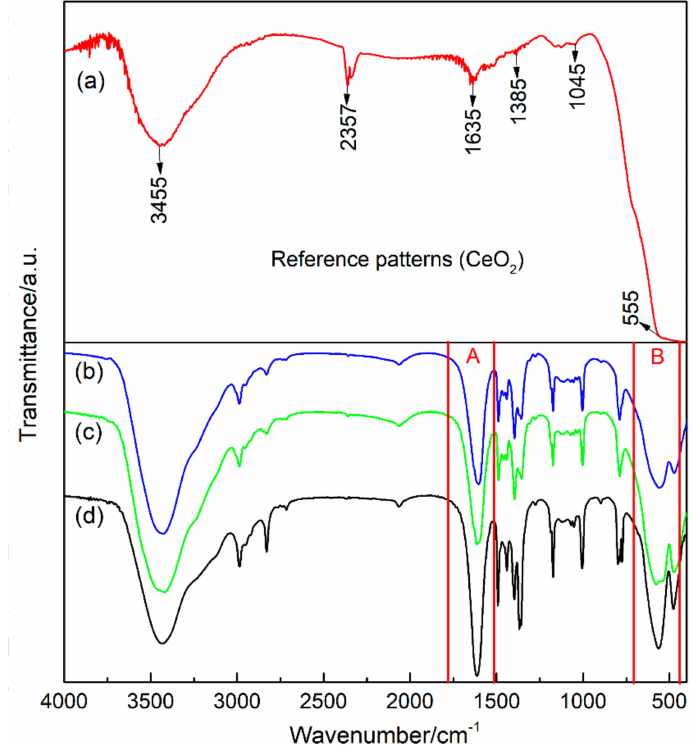
Figure 5. FTIR (Fourier transform infrared) spectra of samples. ( a ) pure CeO 2 ; ( b ) undoped α -Fe 2 O 3 sample; ( c ) Ce-doped α -Fe 2 O 3 sample; ( d ) Bayer α -Fe 2 O 3